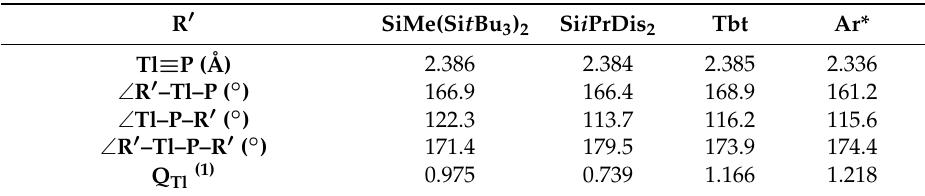
Table 2. The Bond Lengths (Å), Bond Angels ( ◦ ), Singlet—Triplet Energy Splitting ( ∆ E ST), Natural Charge Densities (QTl and QP), Binding Energies (BE), the HOMO-LUMO Energy Gaps, the Wiberg bond index (WBI), and Some Reaction Enthalpies for R (cid:48) Tl ≡ PR (cid:48) at the dispersion-corrected M06-2X/Def2-TZVP Level of Theory. See also Figure